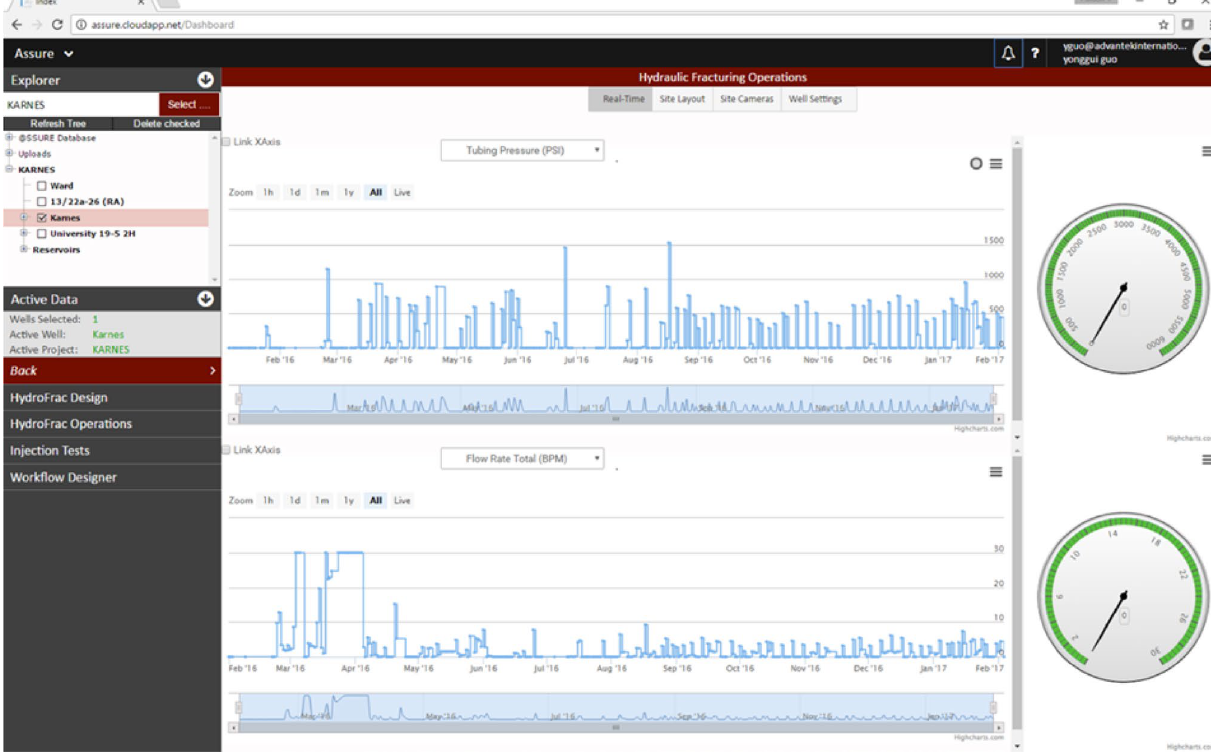
variations of pressure and flow rate as they are down sampled signifi- cantly. The maximum tubing pressure during each injection is